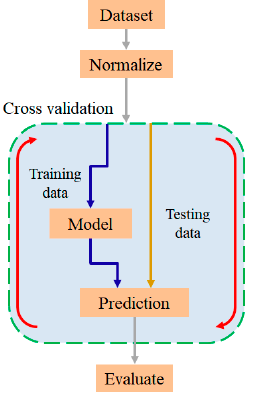
Figure 13. Single model training flowchart.